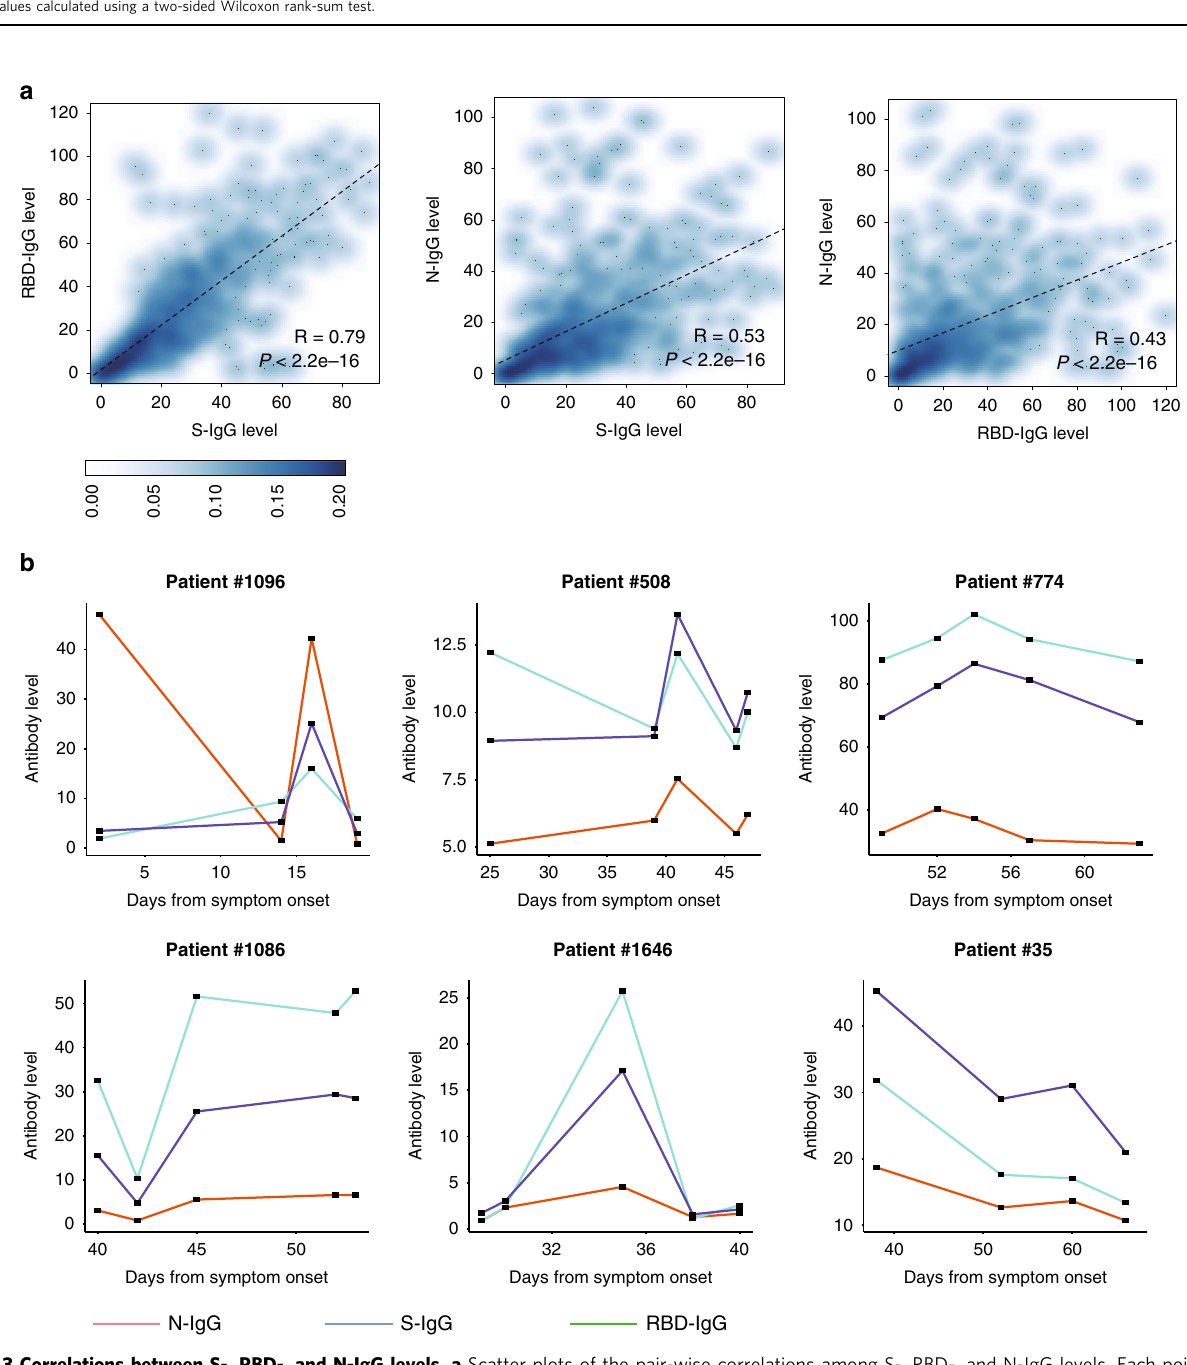
Fig. 3 Correlations between S-, RBD-, and N-IgG levels. a Scatter plots of the pair-wise correlations among S-, RBD-, and N-IgG levels. Each point represents the IgG level of one sample. P values were calculated with the Pearson correlation test. The density of points is shown by color. b Examples of the dynamic changes in the S-, RBD-, and N-IgG